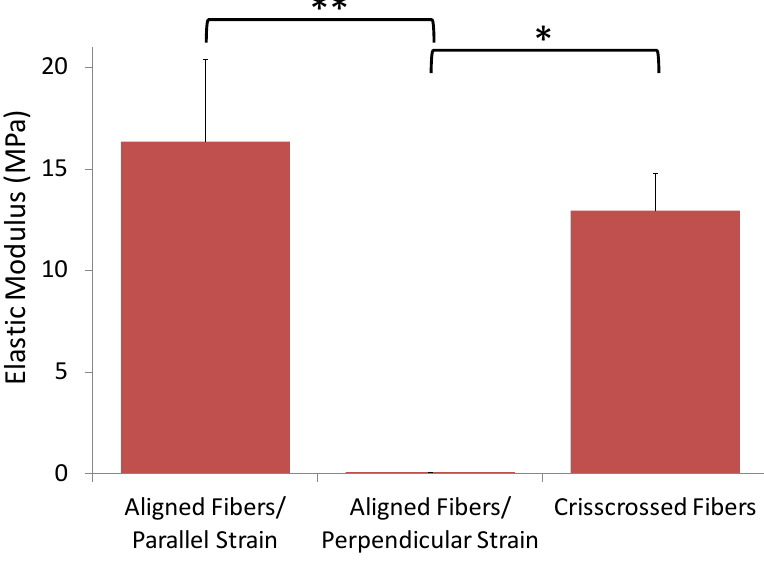
Figure 4. Elastic modulus of composite nanofiber/cell sheets. Constructs with a uniaxial fiber orientation were strained in the directions parallel and perpendicular to the fiber long axis, and constructs with crisscrossed fiber orientation were strained in the direction parallel to one of the two directions of the fiber long axis (* p < 0.05, ** p <